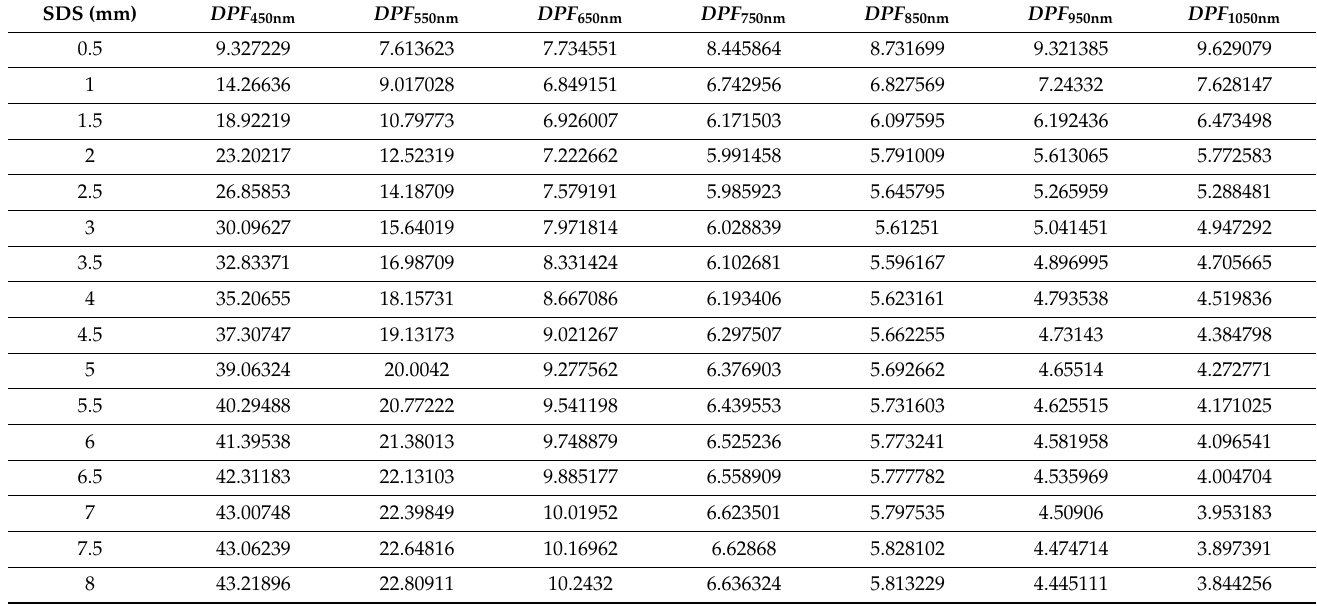
lengths, it was found that increasing the source ‐ to ‐ detector separation decreased the DPF values. Table 2. Estimated DPF based on Equation (7) for different light source wavelengths and source ‐ to ‐ detector separations.